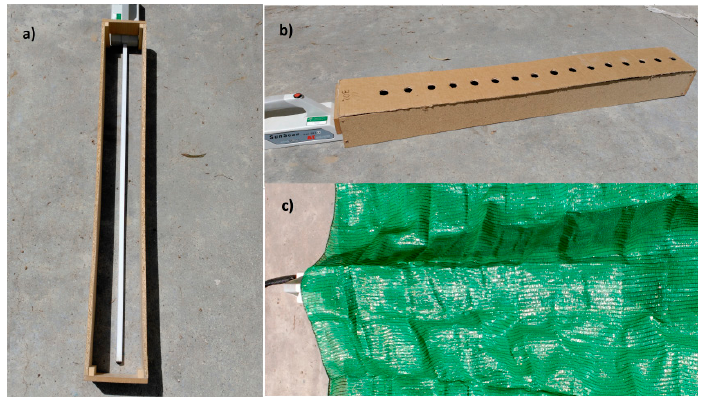
Figure 1. Ceptometer during calibration process. ( a ) Ceptometer with wood structure to avoid diffuse radiation at sun-exposed conditions. ( b ) Ceptometer with wood structure under drilled sheets. ( c ) Ceptometer with wood structure under porous nets.